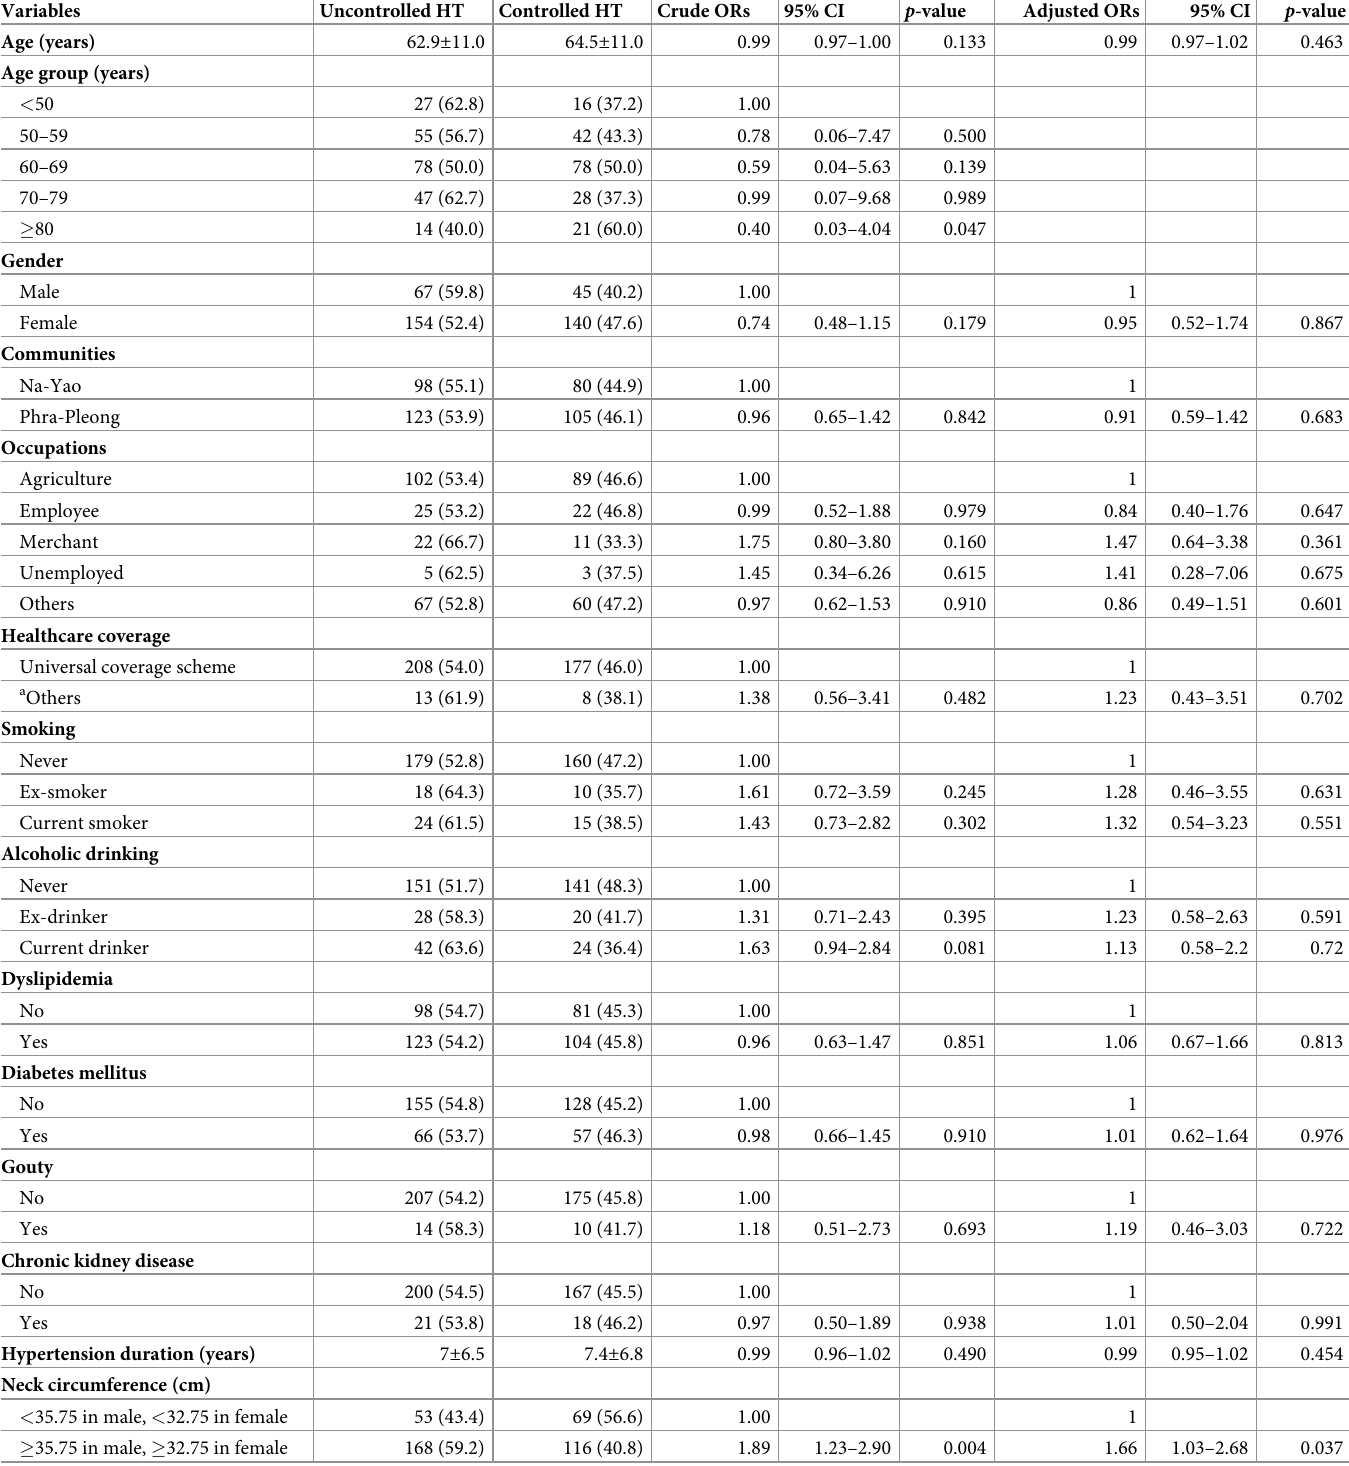
Table 2. Univariate and multivariate logistic regression analysis to assess relationships between potential risk factors associated and uncontrolled hypertension in the rural communities in the central areas of